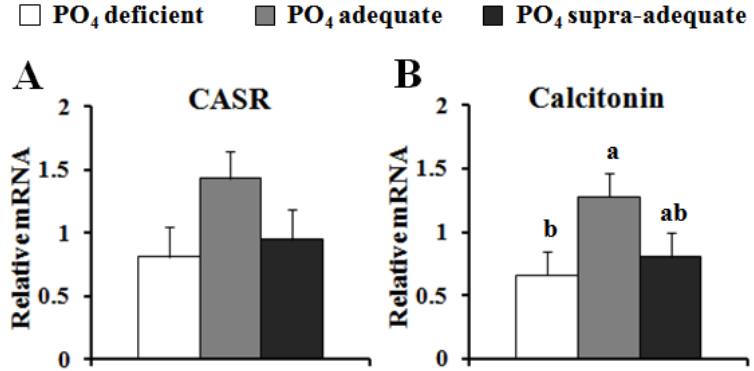
Figure 1. Effect of dietary PO on the gene expression of ( A ) CASR, and ( B ) calcitonin, in 4 the thyroid of neonatal pigs. Values presented are least square means and standard error of values normalized to cDNA concentrations ( n = 7). a,b Values not sharing a common superscript are different ( P <